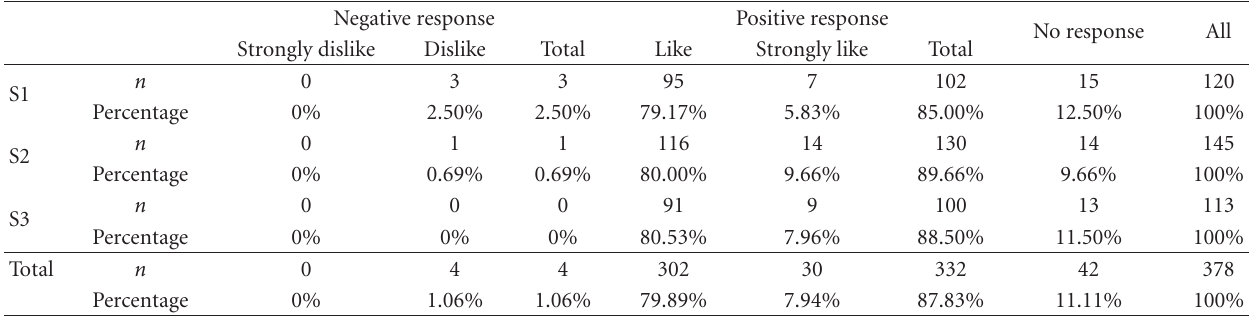
Table 5: Degree of liking of the curriculum by the program implementers.